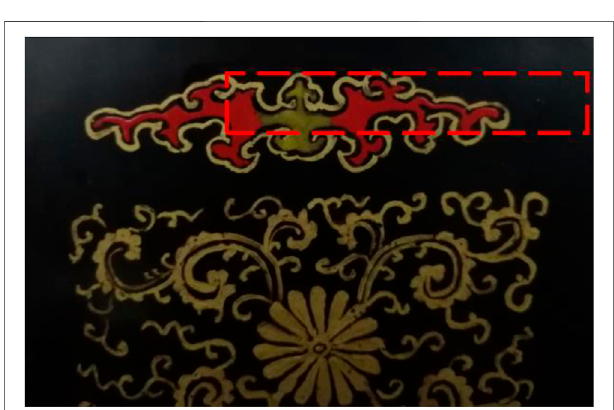
FIGURE 4 | Visible-light picture of the lacquerware replica; red lines mark the scanned area.